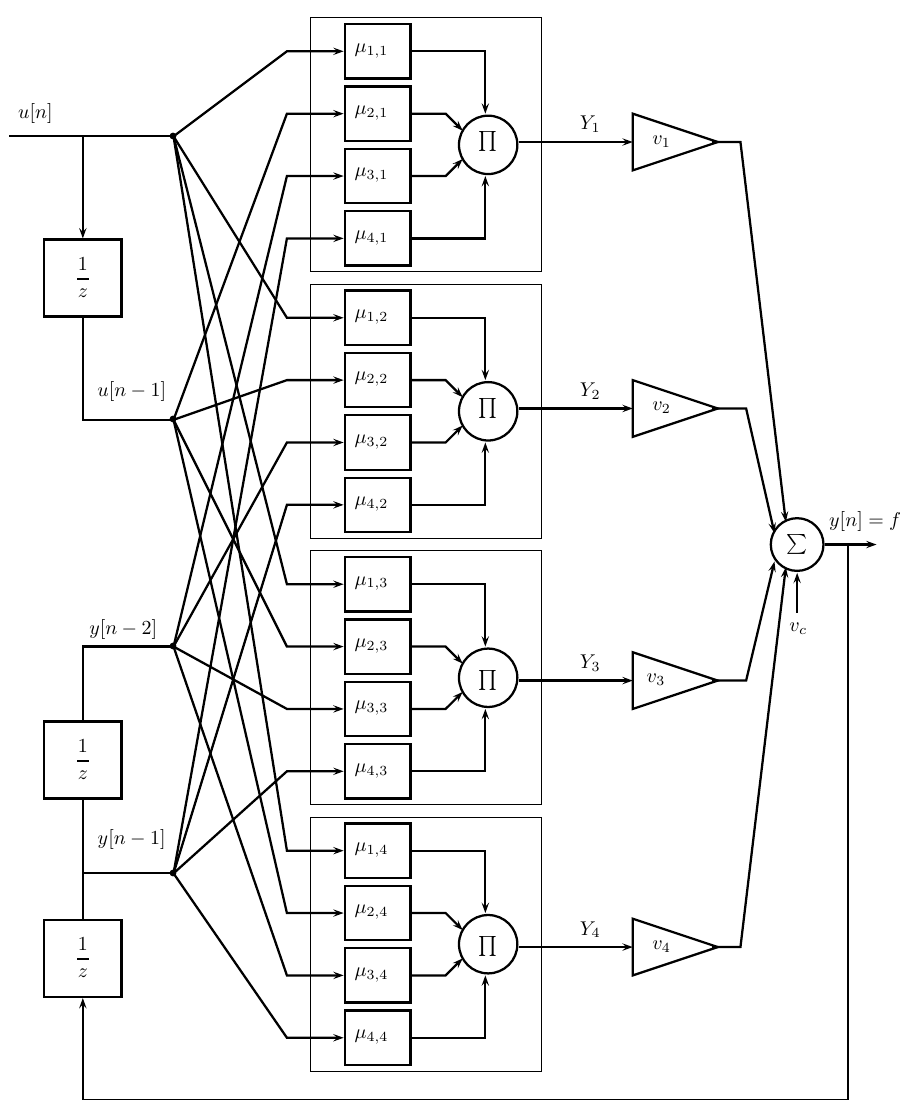
Figure 17. Representation of the neuro-fuzzy system